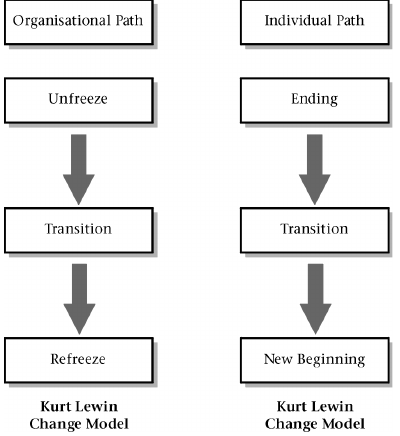
Figure 1: Organisational & individual change process Kurt Lewin